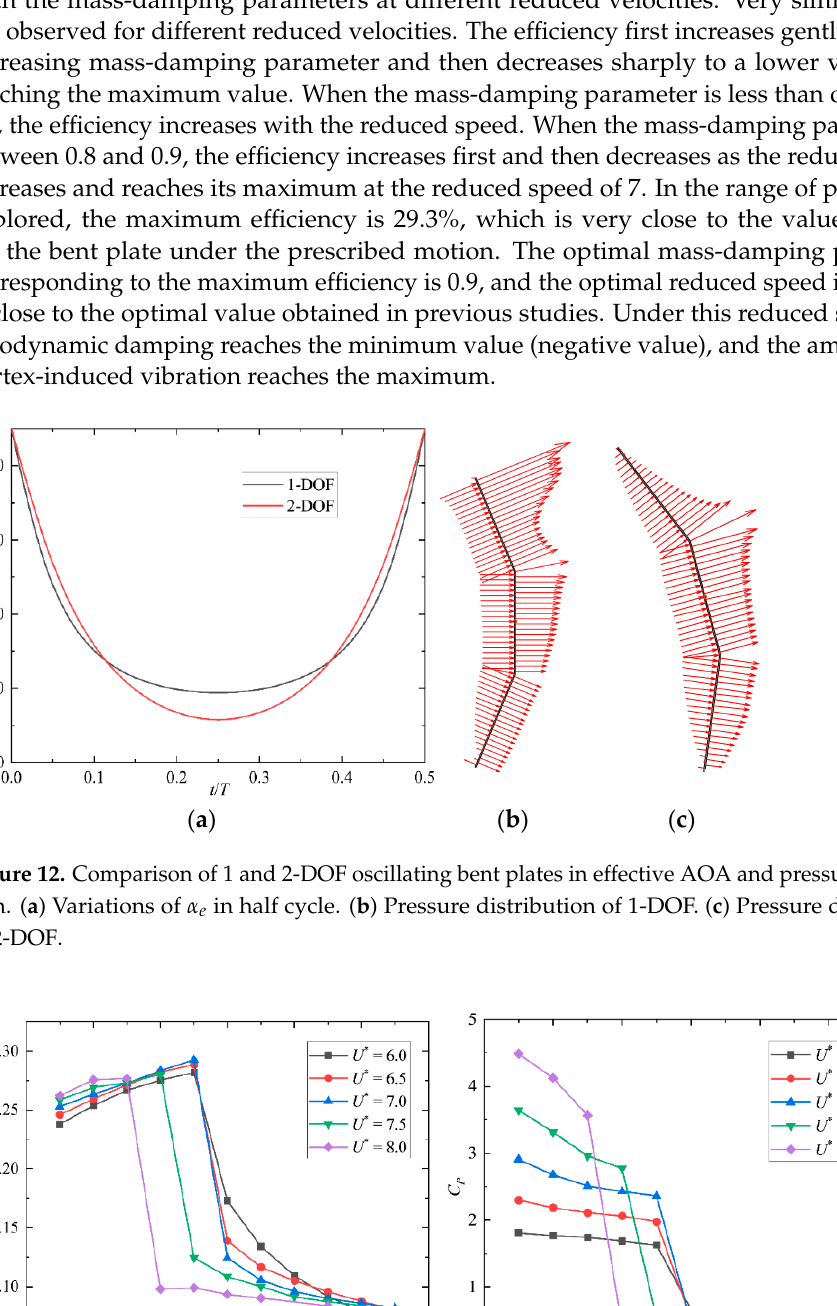
the mass-damping parameter at different reduced velocities. ( a ) Energy harvesting efficiency. ( b )